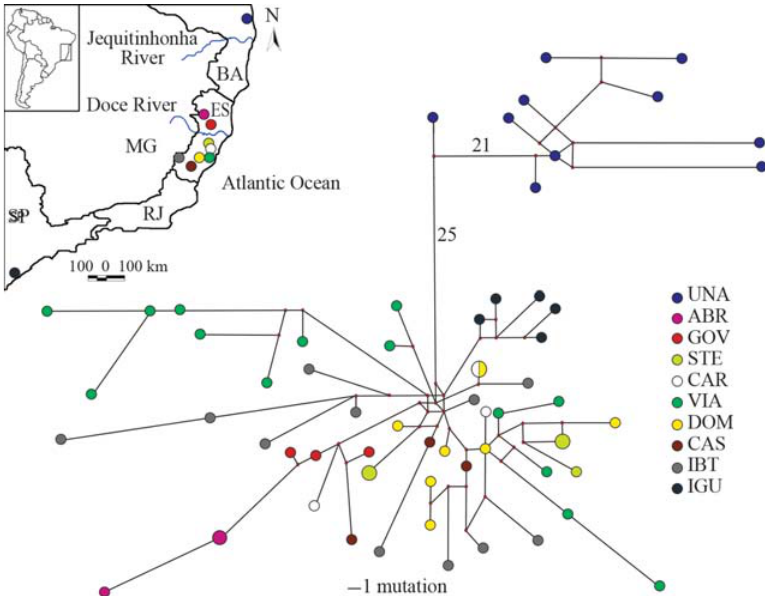
Figure 1 - Map of localities sampled for A. cursor in eastern Brazil and median-joining network of haplotypes. Circle sizes are proportional to haplotype frequency and each circle is colour coded according to the haplotype’s presence at the sampling locations. Unobserved haplotypes are represented by small red circles. Branches are proportional to the number of mutations, except for those with numbers, which represent highly divergent haplotypes with more than 10 mutations. Acronyms, geographic coordinates and altitude of localities are: Bahia state, municipality of Una (UNA, 15°16’ S, 39°04’ W, 66 m),EspíritoSantostate,municipalitiesofÁguiaBranca(ABR,18°52’S,40°49’W,373m),GovernadorLindenberg(GOV,19°16’S,40°28’W,220m), Santa Teresa (STE, 19°55’ S, 40°36’ W, 950 m), Cariacica (CAR, 20°16’ S, 40°25’ W, 780 m), Viana (VIA, 20°24’ S, 40°29’ W, 25 m), Domingos Mar- tins (DOM, 20°22’ S, 40°40’ W, 701 m), Castelo (CAS, 20°36’ S, 41°11’ W, 262 m) and Ibitirama (IBI, 20°29’S, 41°43’W, 935-1063 m), and São Paulo state, municipality of Iguape (IGU, 24°42’ S, 47°34’ W, 144